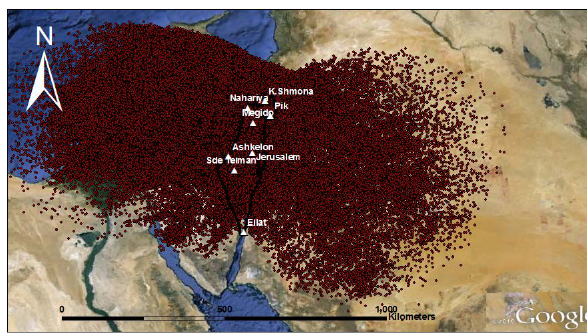
Fig. 1. The study region. Brown dot for each flash detected during the study period. White triangles denote the locations of the ILLS sensors.